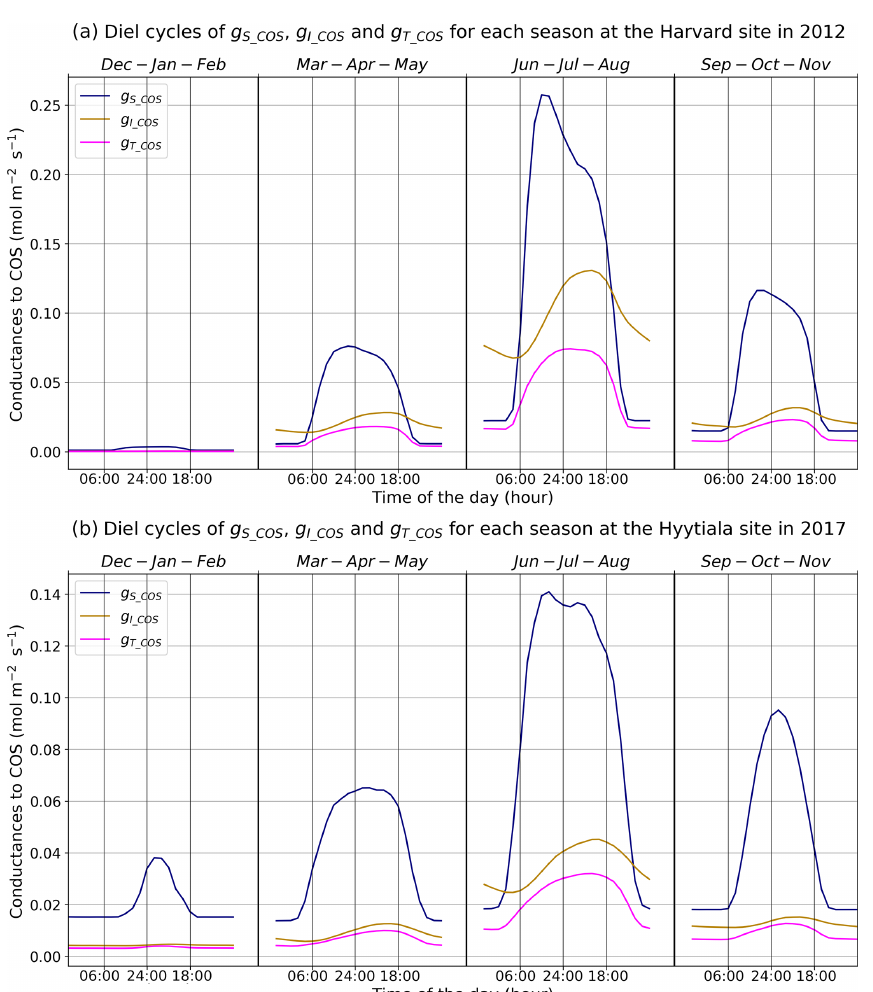
Figure 3. Mean diel cycles of simulated conductances for each season at Harvard Forest in 2012 (a) and Hyytiälä in 2017 (b) . The area reference for the units is square metres of ground